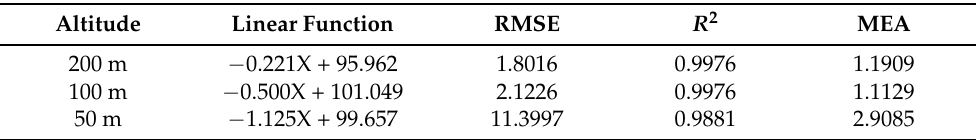
Table 3. The effect of a drone’s altitude on the performance; the results are presented for location #3 and various altitudes, with a drone speed of 5 m/s (18 km/h).